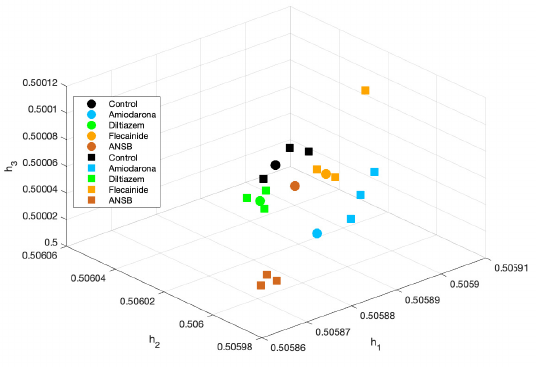
Figure 6. Latent space for the 27 signals using an ERB scale and 256 bands. The squares correspond to the training signals and the circles to the testing